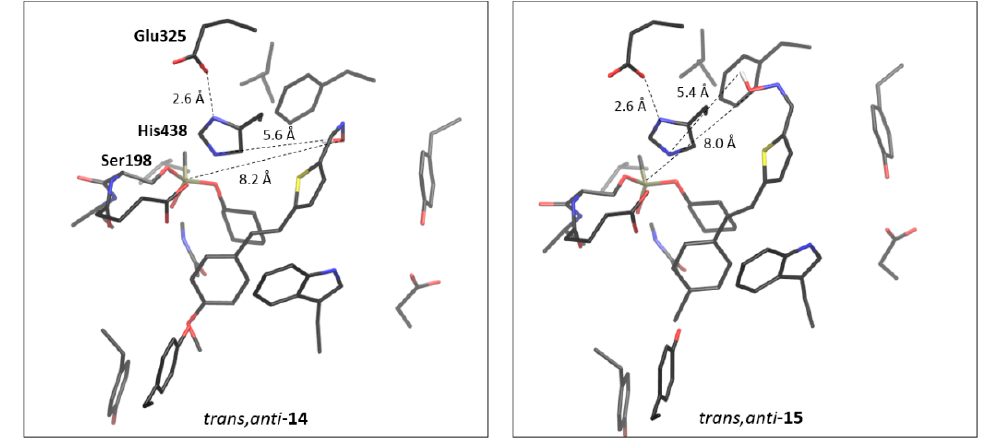
Figure 6. The most favorable conformation of trans,anti - 14 and trans,anti - 15 docked into the active site of cyclosarin-inhibited BChE. site of cyclosarin-inhibited